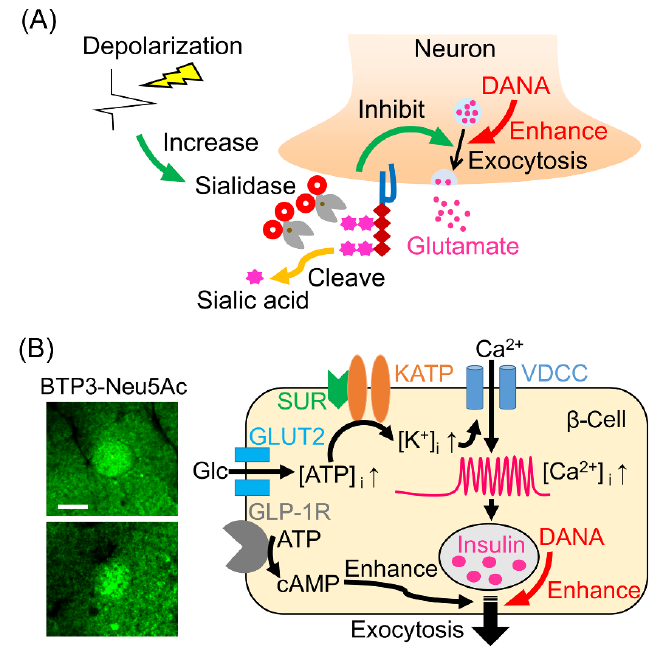
Figure 3. Effects of the sialidase inhibitor DANA on the release of glutamate and insulin. ( A ) Negative feedback on neural excitation by sialidase. DANA promotes the release of glutamate. ( B ) Distribution of sialidase activity in the mouse pancreas (left, scale, 0.1 mm). DANA promotes insulin secretion (right). Glc, glucose; GLP-1R, glucagon-like peptide-1 receptor; GLUT2, glucose transporter 2; KATP, ATP-sensitive potassium channel; SUR, sulfonylurea receptor; VDCC, voltage-dependent calcium channel.